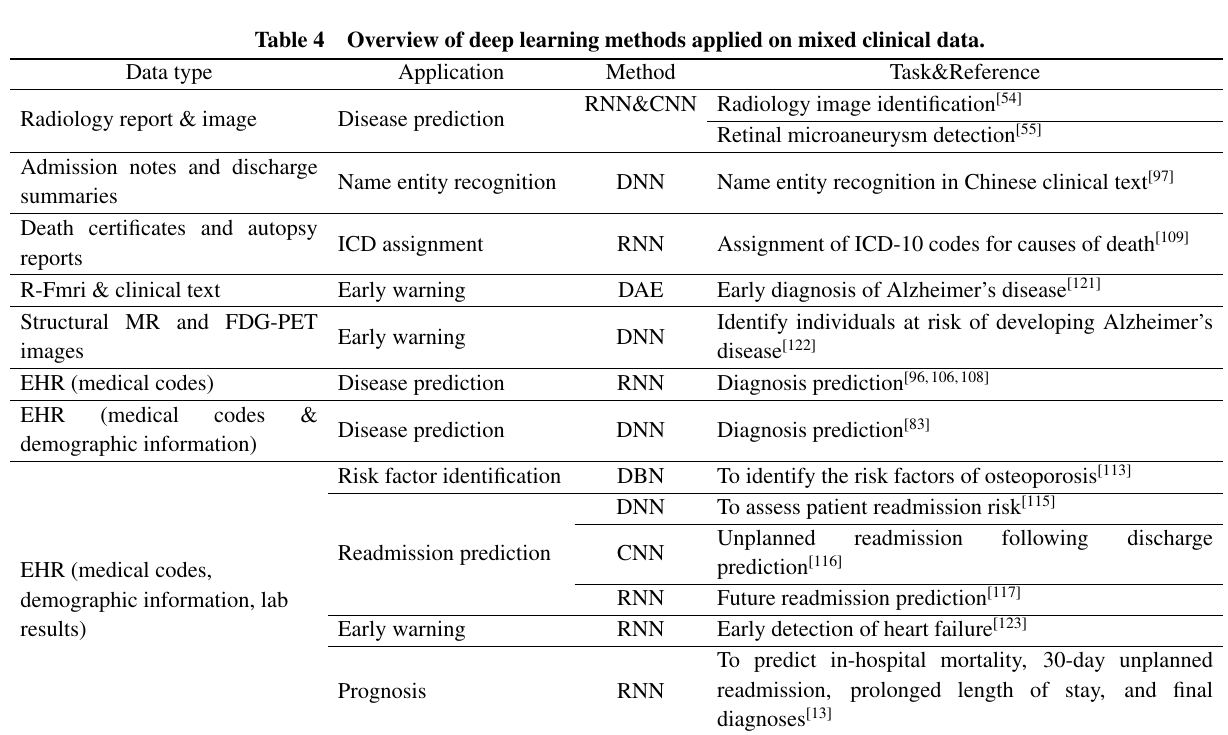
Table 4 Overview of deep learning methods applied on mixed clinical